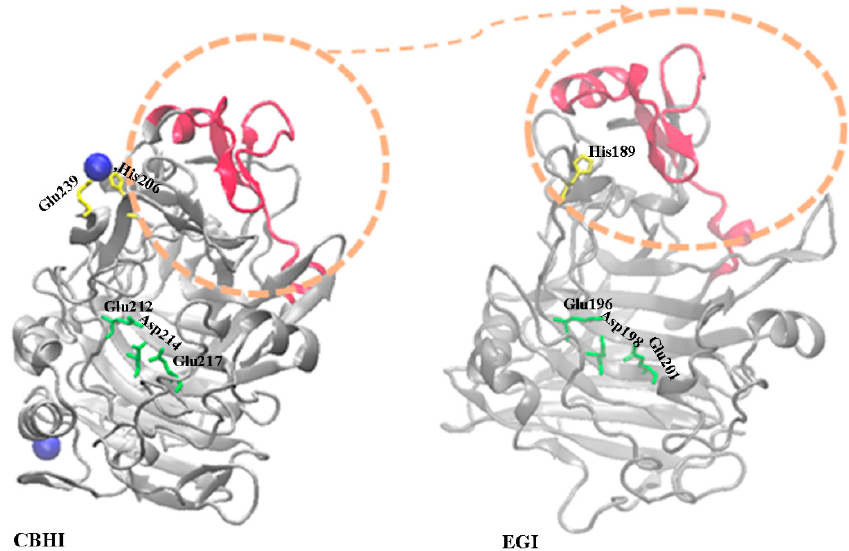
Figure 1. The rationality of the swapping approach. The crystal structures of CBHI (PDB id: 1DY4) and EGI (PDB id: 1EG1) are drawn by colouring the swapped-domain in red. The catalytic residues of CBHI, Glu212, Asp214 and Glu217, and EGI, Glu196, Asp198 and Glu201, are depicted in ‘licorice’ format and coloured as ‘green’. The His206 and Glu239 residues directly linked to Co 2+ in CBHI’s structure is drawn in ‘licorice’ format and colored as ‘yellow’. To perform distance measurement and visualization of the structure, the Visual molecular dynamic is used